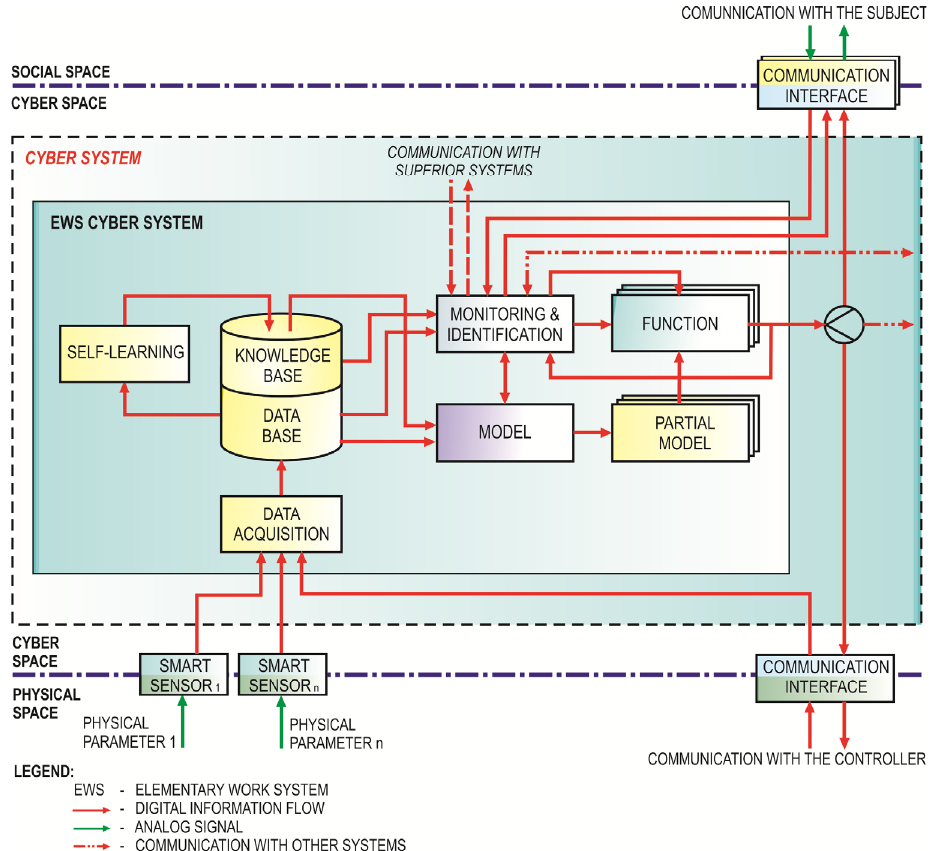
Figure 10. Structure of the EWS cyber system in the CPPS concept [3]. According to [3,25] the basic structure of the EWS cyber system is divided into three basic parts: (1) the data-acquisition part, (2) the self-learning part, and (3) the state-monitoring and identi fi cation part.